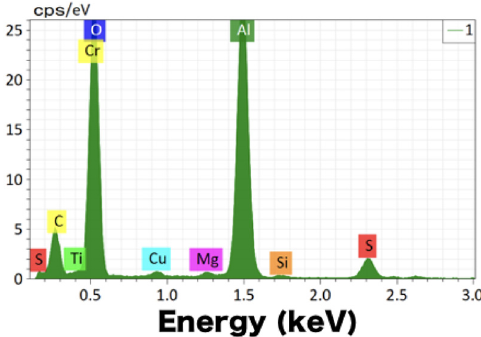
Fig. 4. EDX spectrum acquired from the interfacial region of the joint with NMT1 surface treatment indicated as the region in Figure